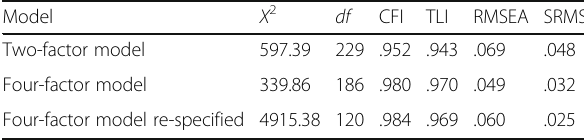
Table 1 Goodness of fit indexes for the proposed models Model X 2 df CFI TLI RMSEA SRMS Two-factor model